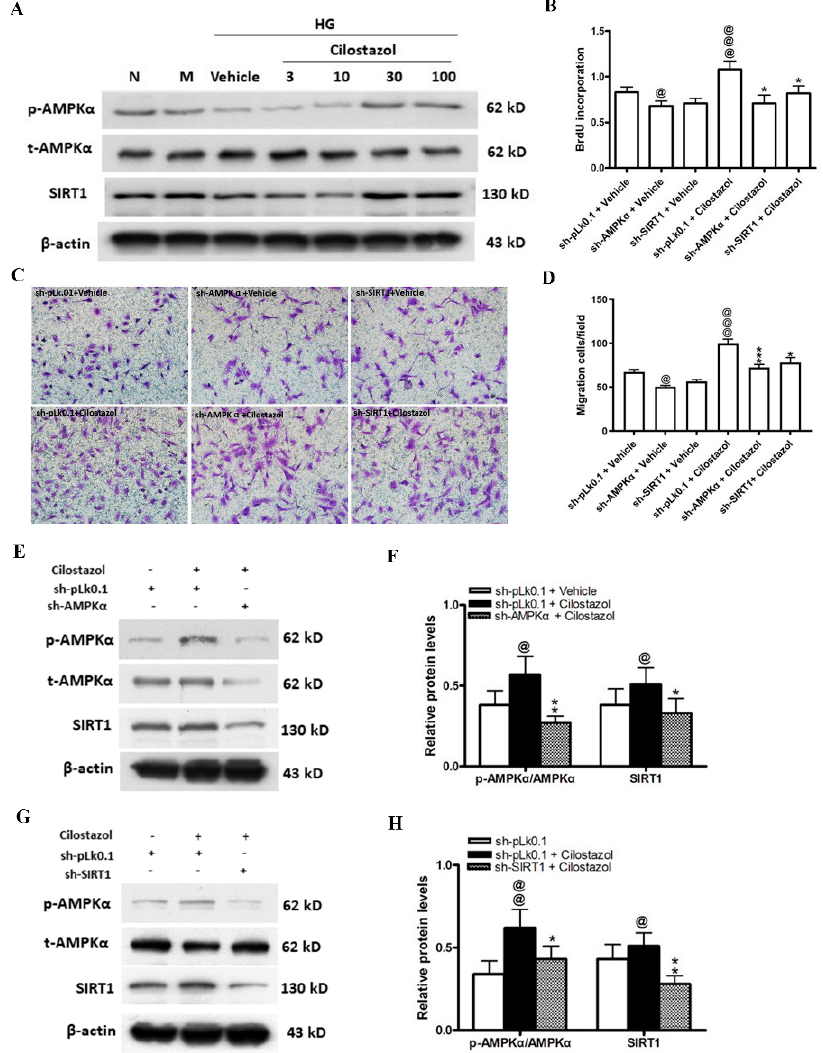
Figure 3. Cilostazol upregulated the AMPK/SIRT axis in HUVECs pretreated with HG. ( A ) Cilostazol stimulated the phosphorylation of AMPK α and SIRT1 activity in a dose-dependent manner, with peak effects at 100 µ M of cilostazol. ( B ) Quantification of BrdU incorporation data of HUVECs transfected with AMPK α or SIRT1 shRNA and cocultured with or without cilostazol-treated HASMCs for 24 h. ( C ) Representative images ( × 200) of migrating cells stained with crystal violet. ( D ) Quantification of migrating cells. (E – H ) Western blot assays of AMPK α and SIRT1 in HUVECs transfected with AMPK α shRNA ( E ), SIRT1 shRNA ( G ), or nontargeting pLk0.1 shRNA and cocul- tured with HASMCs treated with vehicle or cilostazol. ( F , H ) Quantification of Western blot data. The results are represented as the mean ± S.E.M. from three independent experiments performed in